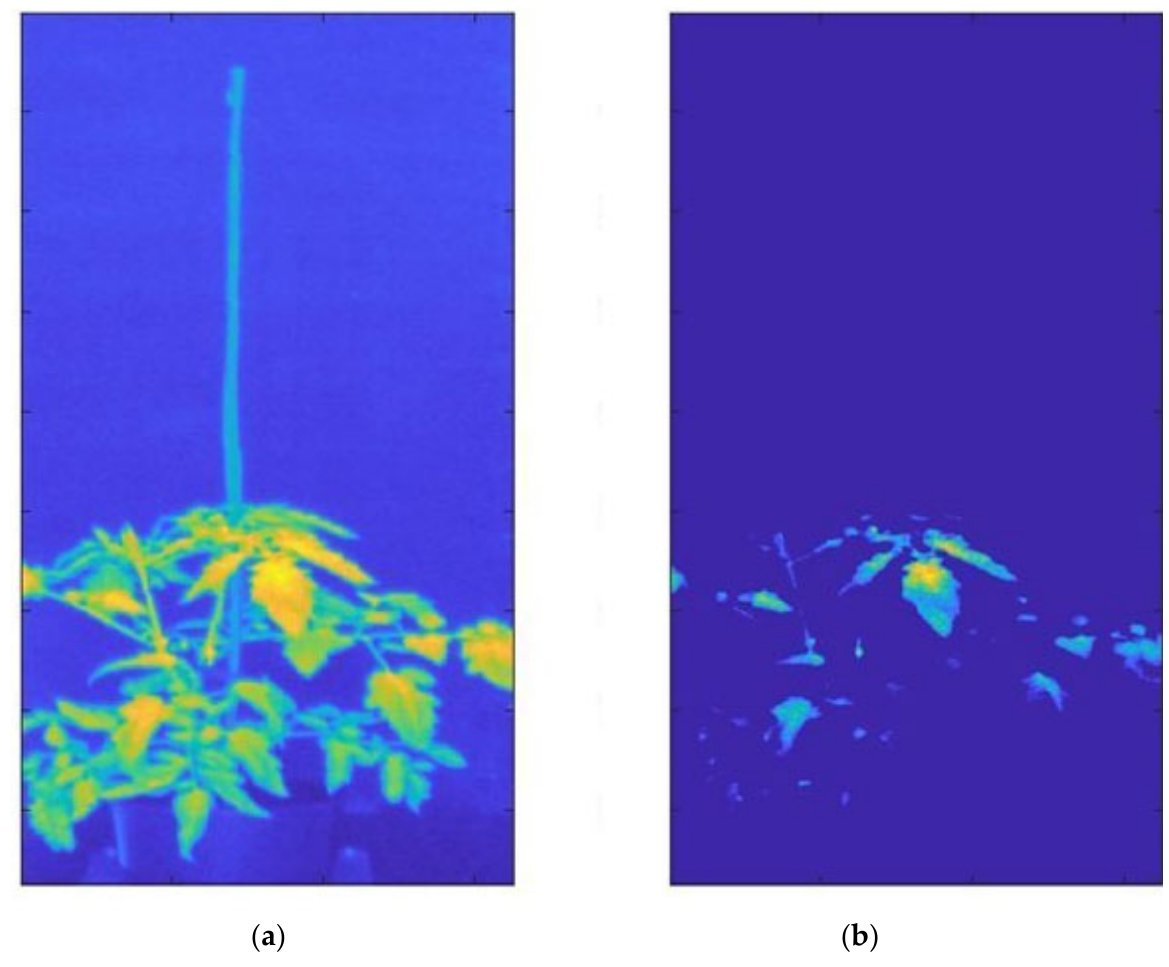
Figure 3. Example of segmentation results. The segmentation process based on the 96° percentile was applied to a Red Setter tomato genotype control thesis acquired on 8 June 2021. The original HI ( a ), composed of 1,048,576 pixels, was reduced to 11,408 pixels ( b ), permitting the sampling of the plant regions characterized by direct and orthogonal illumination.